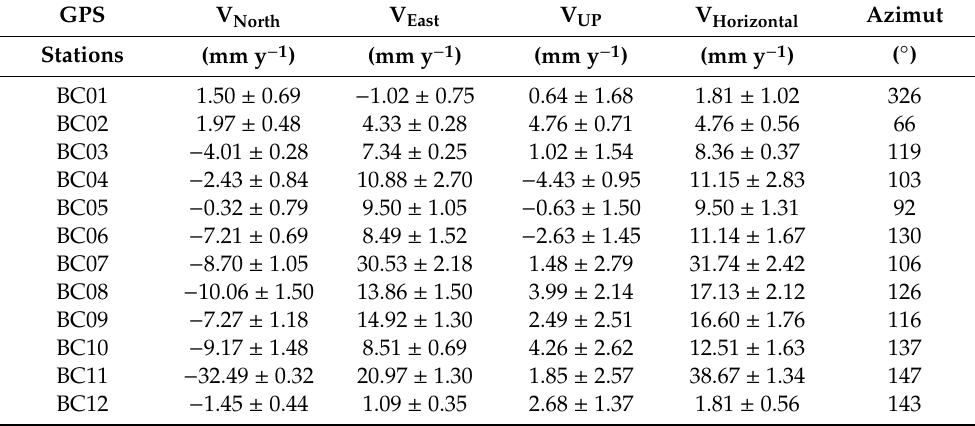
Table 5. Relative rates and errors ( ± σ ) of Global Positioning System (GPS) stations detected after five campaigns from 2012 to